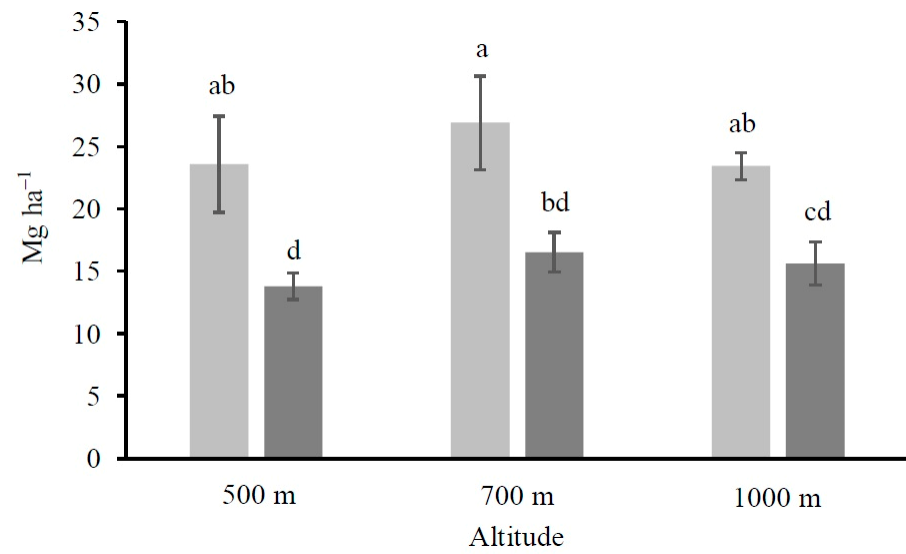
Figure 3. Organic carbon stock at the 0–20 cm depth interval of the soils under the broadleaf (light bars) and pine (dark bars) forests at 500, 700 and 1000 m a.s.l., Mount Cucco massif (Central Apennines, Italy). Error bars are the standard errors ( n = 3). Di ff erent letters indicate significant di ff erences among vegetation types and altitudes according to Tukey’s test ( p < 0.05).